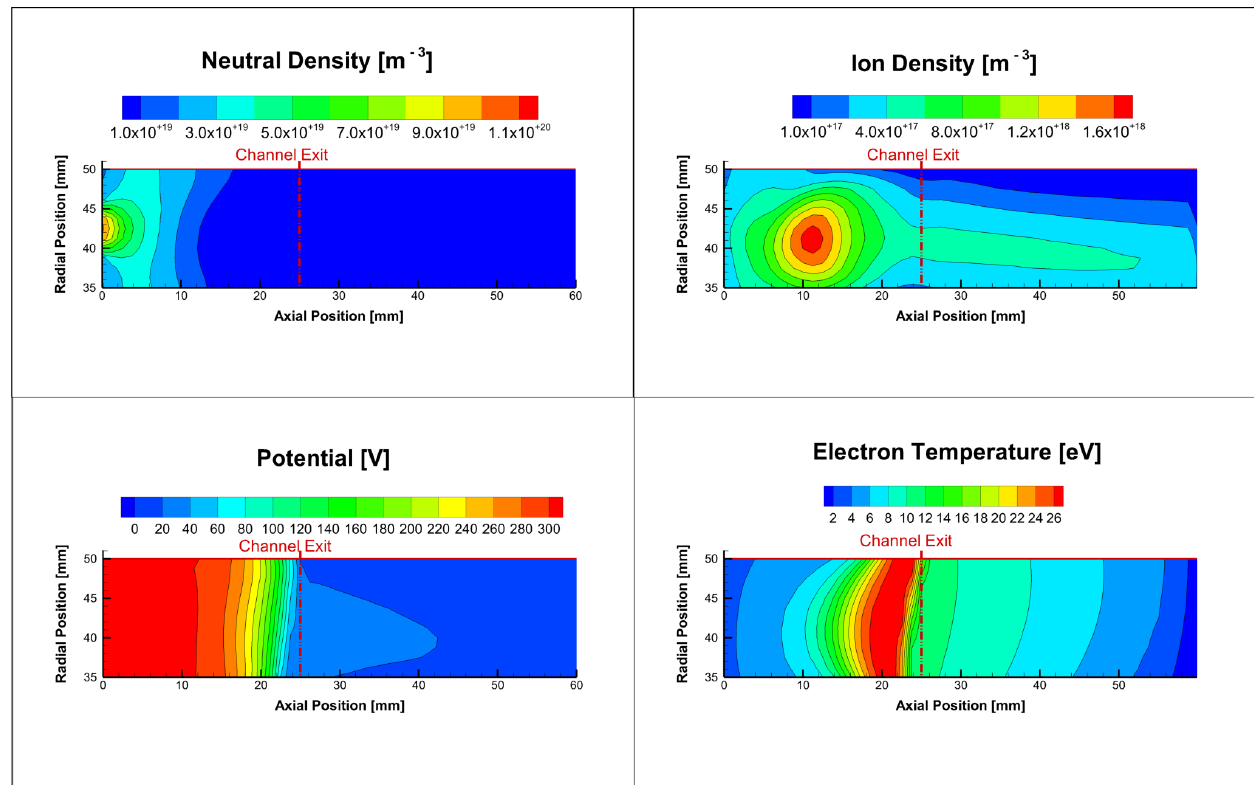
Figure 14. SPT-100 simulation: Test 106 . Time-averaged contour plots of neutral and plasma densities, potential and electron temperature. Average window: 1